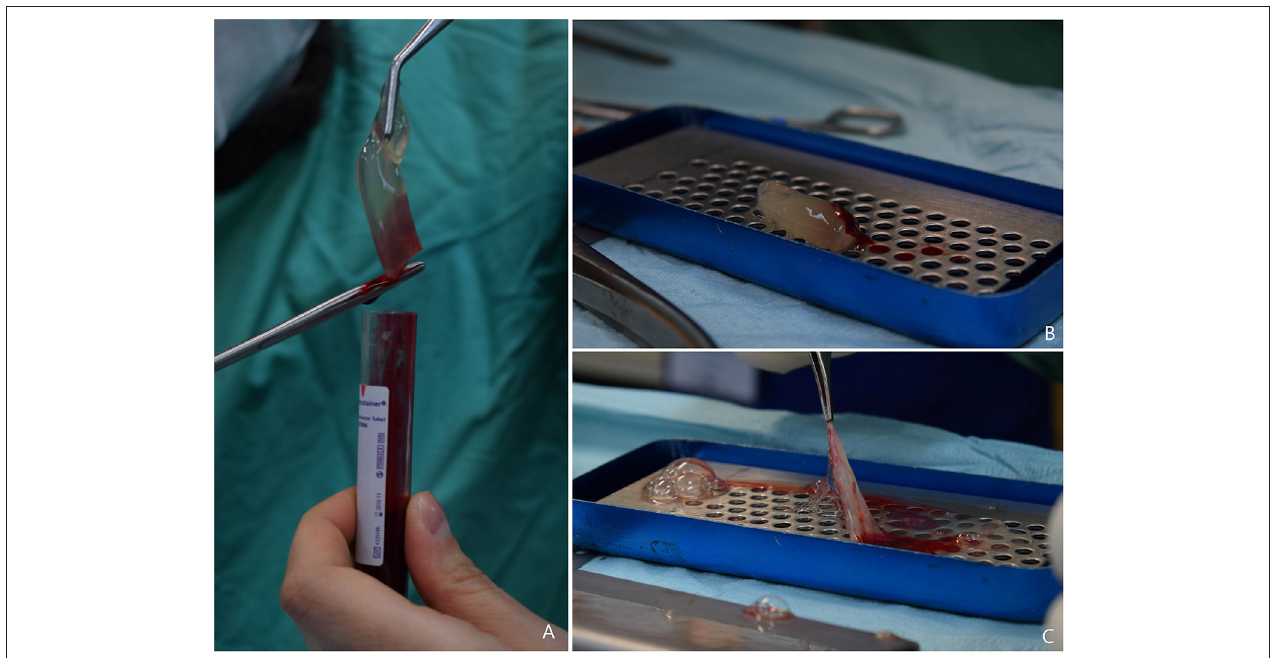
FIGURE 1 | (A) L-PRF clot obtained after centrifugation, the red clot is gently removed using scissors; (B) L-PRF inside the Wound Box ( courtesy of Dr. A. Crisci ); (C) L-PRF membrane obtained after 15min compression.